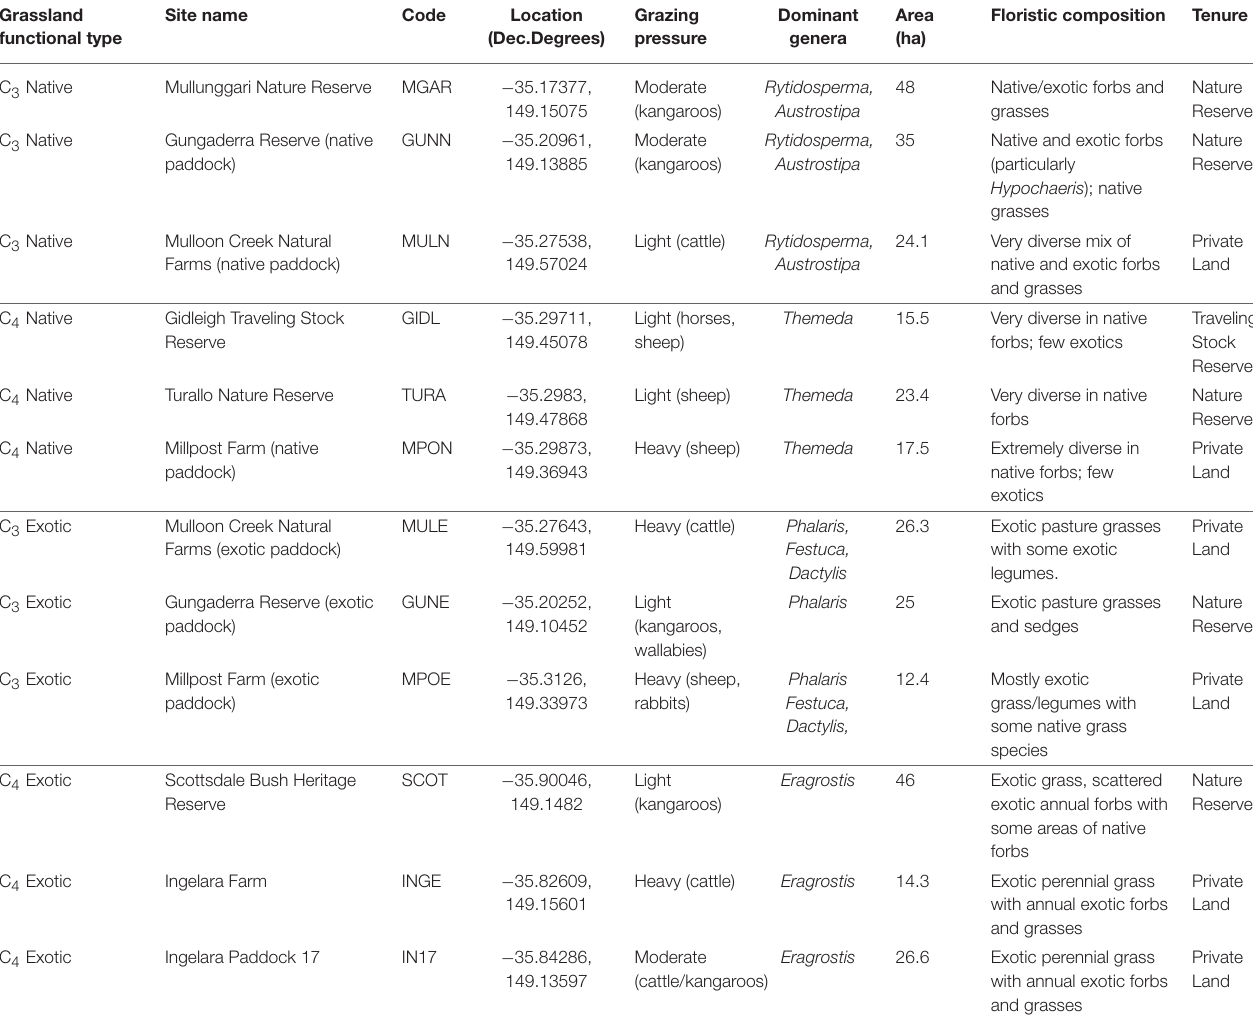
TABLE 1 | Characteristics of study sites by grassland functional